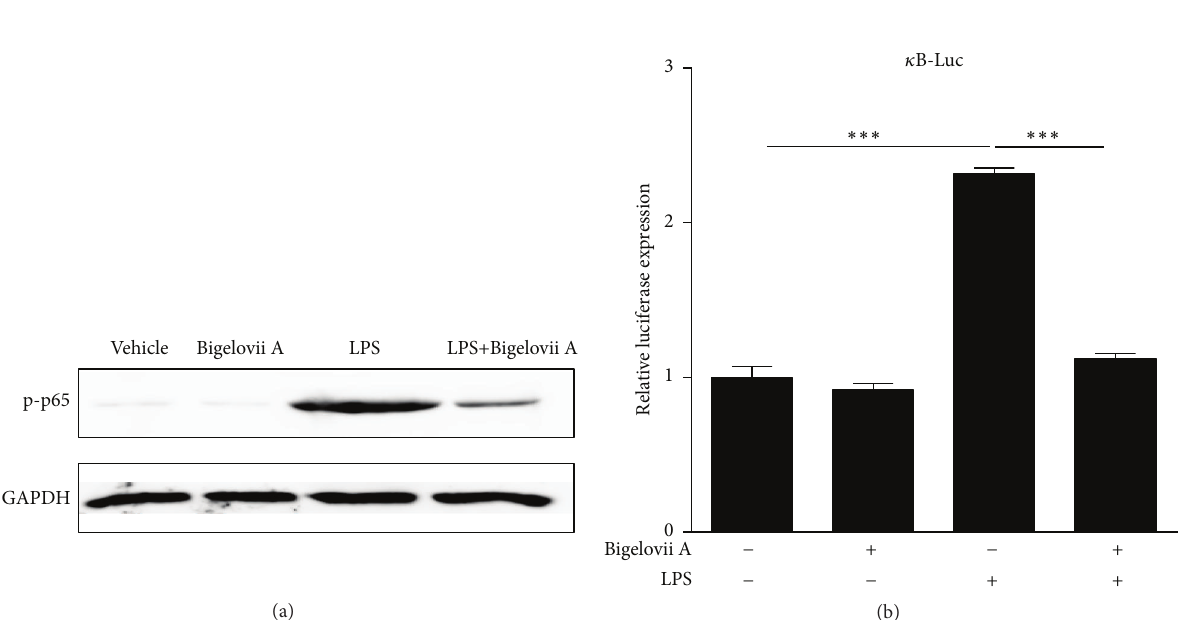
Figure 8: Effect of Bigelovii A on NF- 𝜅 B activation during LPS-induced inflammation in MH-S cells. (a) MH-S cells were pretreated with or without 10 𝜇 M of Bigelovii A for 1h, followed by treatment with PBS or 100ng/mL of LPS for 3 h, and total proteins were isolated. Western blot was performed by using antibodies against NF- 𝜅 B p-p65 and GAPDH, respectively. (b) MH-S cells were transiently transfected with total of 0.5 𝜇 g indicated plasmids. 48 h after transfection, the cells were pretreated with or without 10 𝜇 M of Bigelovii A for 1h, followed by treatment with PBS or 100ng/mL of LPS. 4h later, the cells were lysed, and luciferase activity was measured. Luminometer values were normalized for expression from a cotransfected pRL-TK gene and negative control sequentially. Results are reflected by means ± SEM ( 𝑛 = 3 ). ∗ ∗ ∗ indicated statistically significant difference, 𝑝 < 0.001 . Negative control: cells treated by Vehicle plus PBS. Positive control: cells receiving LPS plus Vehicle